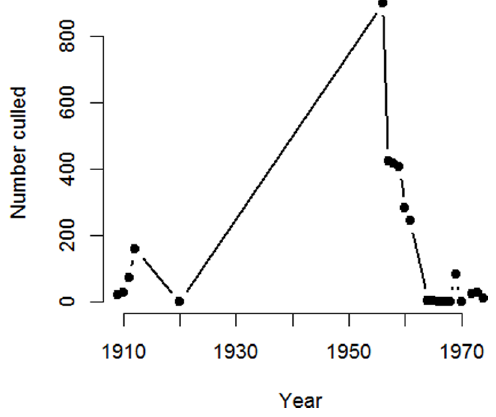
Figure 3. Number of Lycaonpictus recorded as killed by hunters in Zimbabwe between 1909 and 1974.